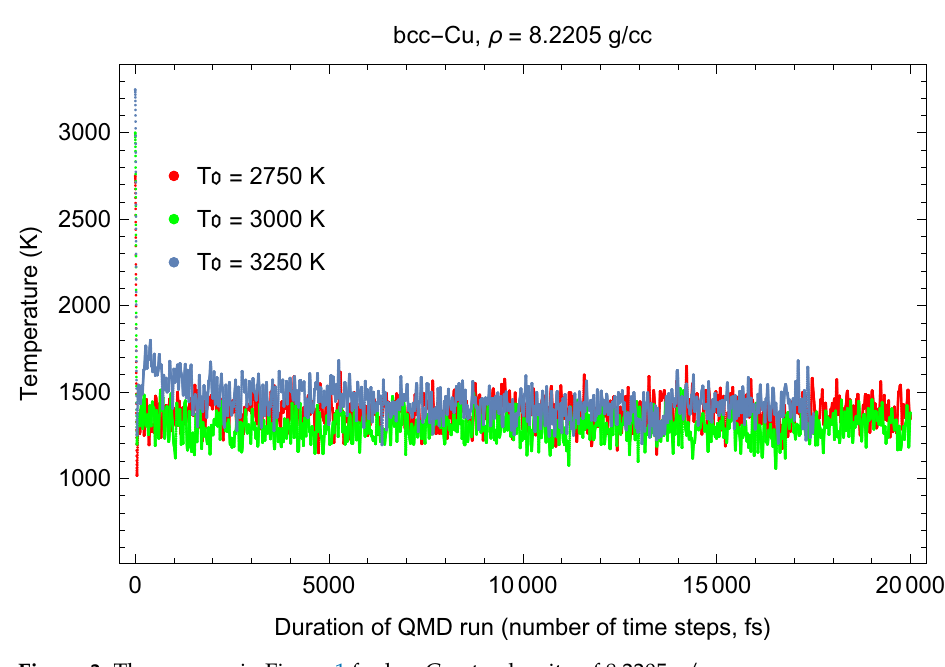
Figure 3. The same as in Figure 1 for bcc-Cu at a density of 8.2205 g/cc.